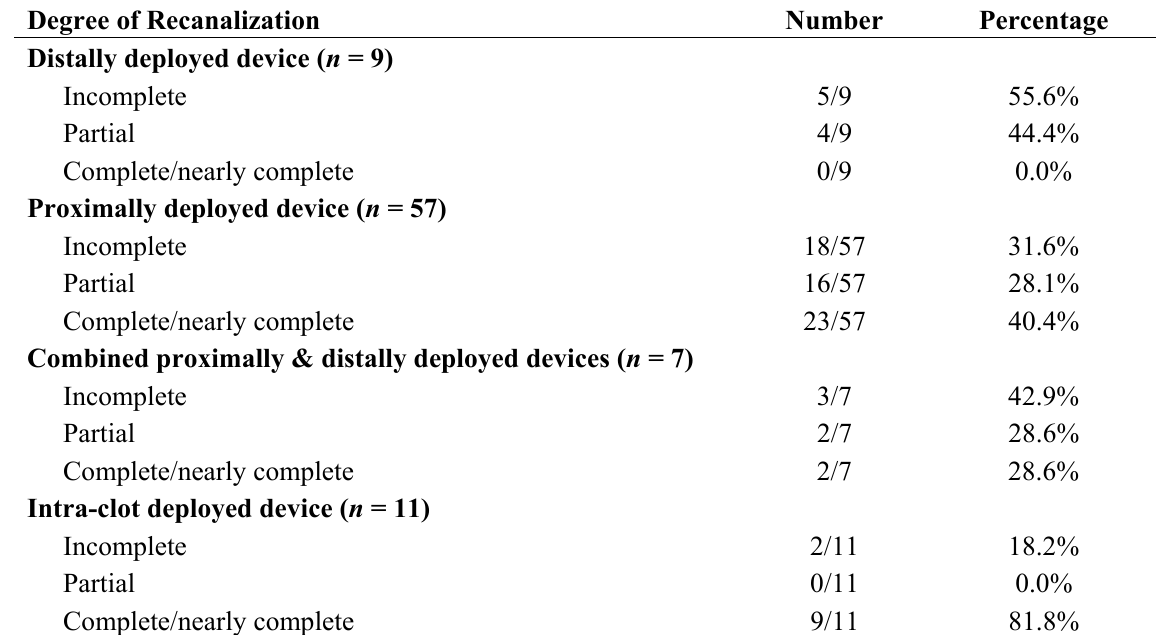
Table 2. Degree of recanalization stratified by type of device